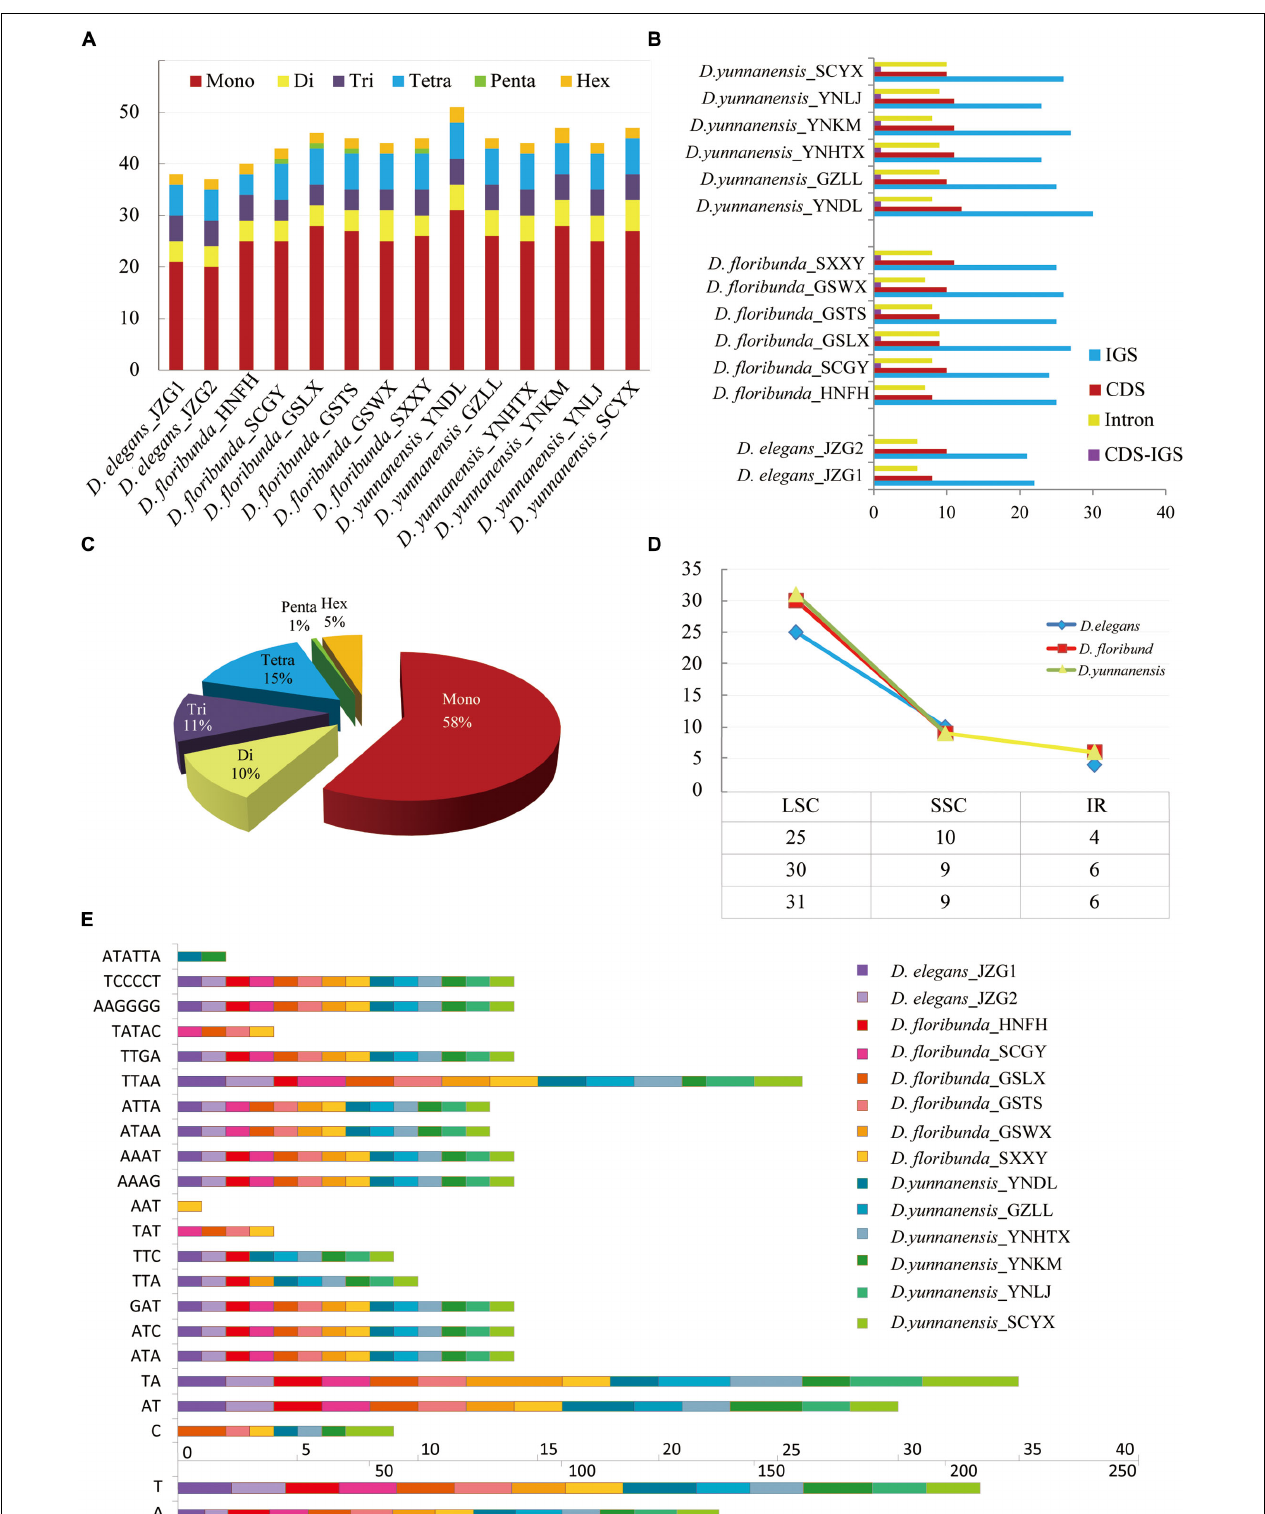
FIGURE 3 | Analysis of simple sequence repeats (SSRs) in 14 plastomes. (A) The number of different SSR types detected in each individual. (B) Frequency of SSRs in the intergenic regions, protein-coding genes, intron, and CDS-IGS (partly in CDS and partly in IGS). (C) Proportion of different SSR types in 14 Dipelta individuals. (D) Average frequency of SSRs in three species distributed in LSC, IR, and SSC region. (E) Type and frequency of each identified